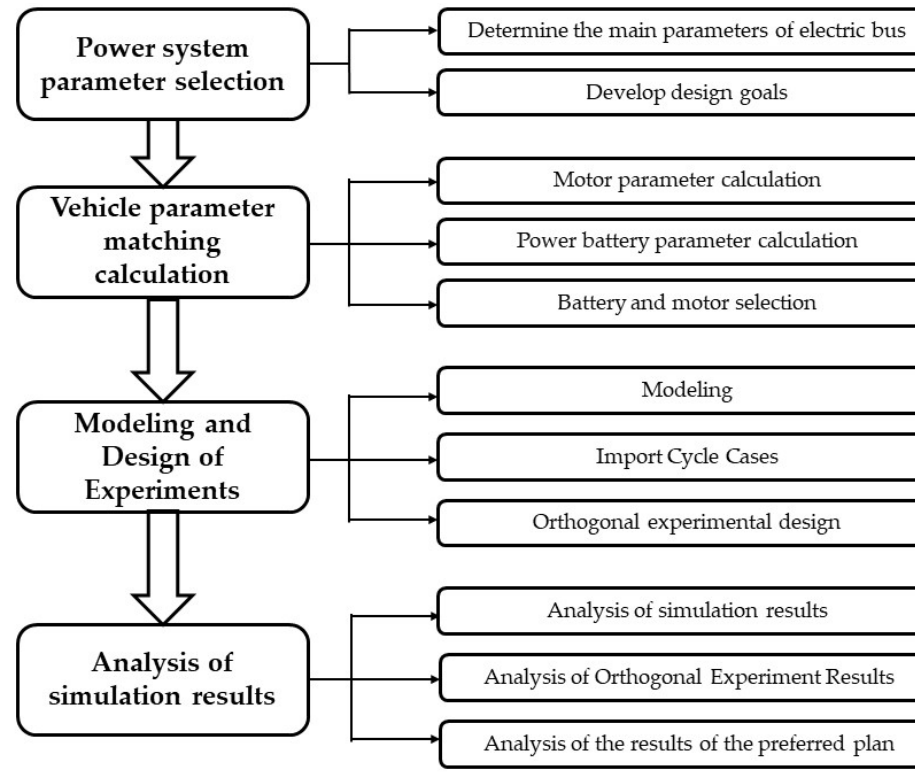
Figure 1. Structure flow chart.